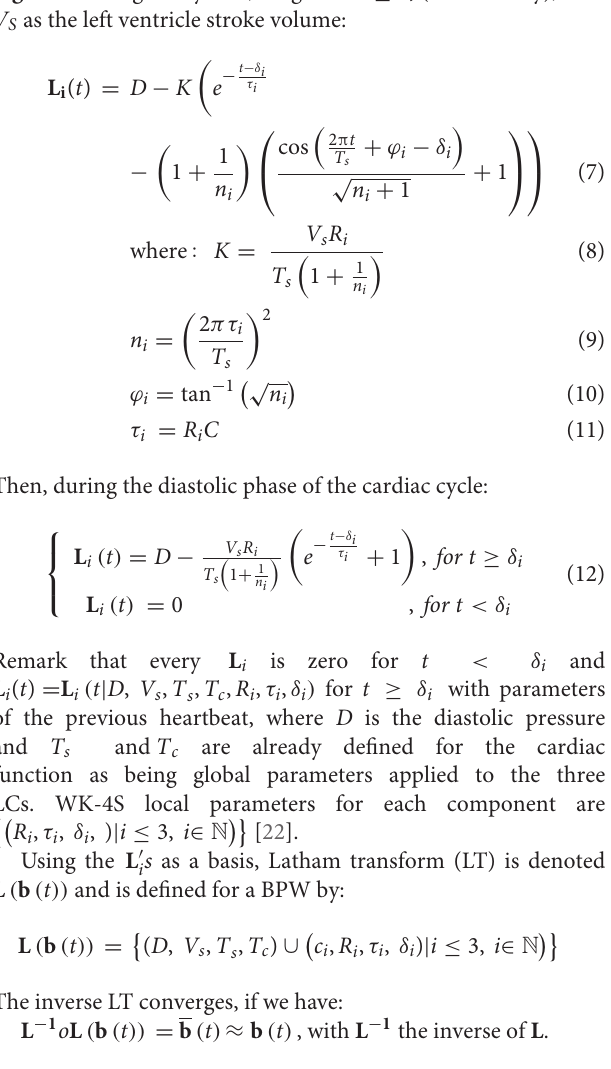
Solving p ( t ) for each i th component in the LRC circuit